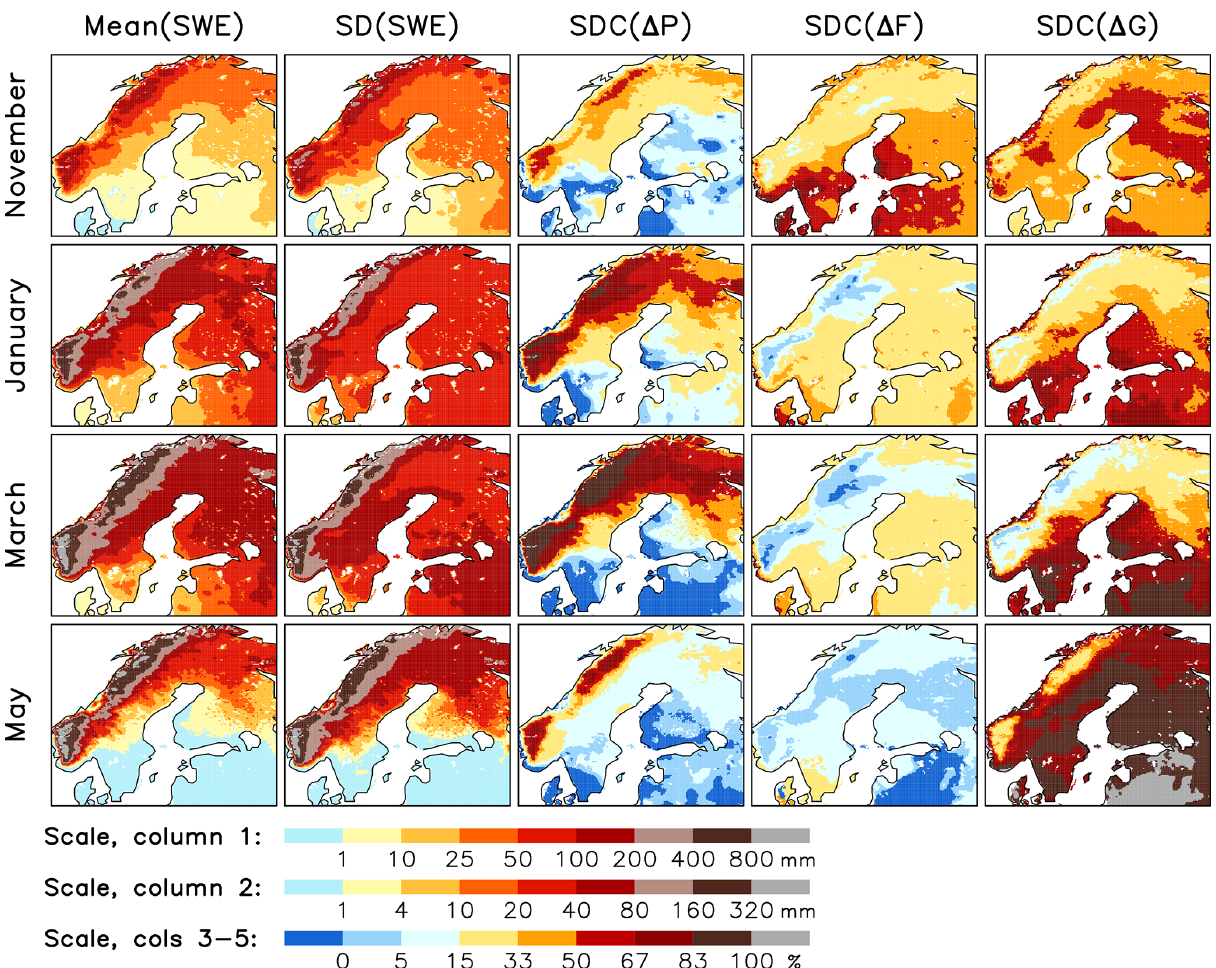
Figure 7. Statistics of SWE in ERA5-Land for winters 1981/82 to 2019/20. Columns 1–2: mean and interannual standard deviation of SWE (in mm). Columns 3–5: relative contributions of total precipitation ( (cid:49)P ), the snowfall fraction ( (cid:49)F ) and the snow-on-ground fraction ( (cid:49)G ) to the standard deviation of SWE (in %). The colour scales are given at the bottom of the